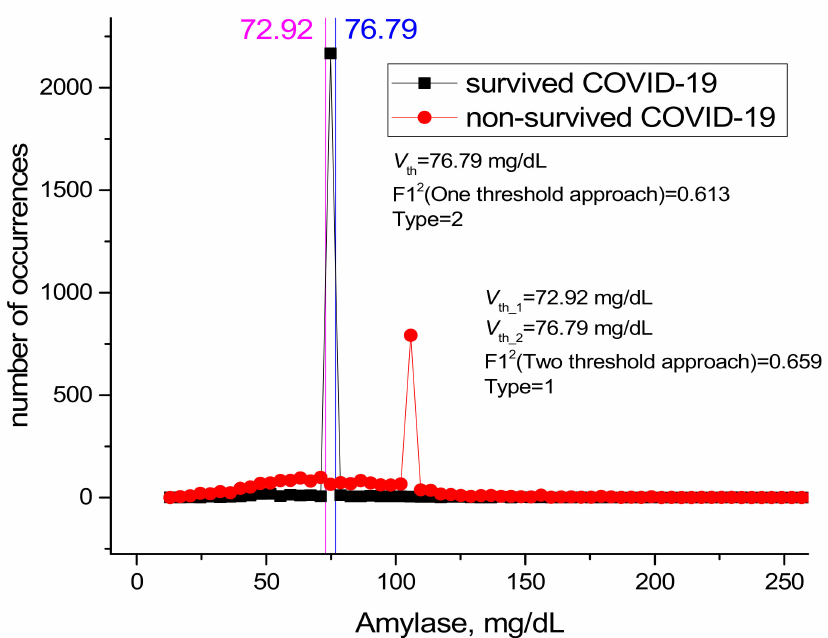
Figure 10. Histogram distributions and F1 2 results of amylase feature according to two-threshold value approach in estimating COVID-19 mortality. V th_1 (pink line) and V th_2 (blue line) is the threshold for detecting COVID-19